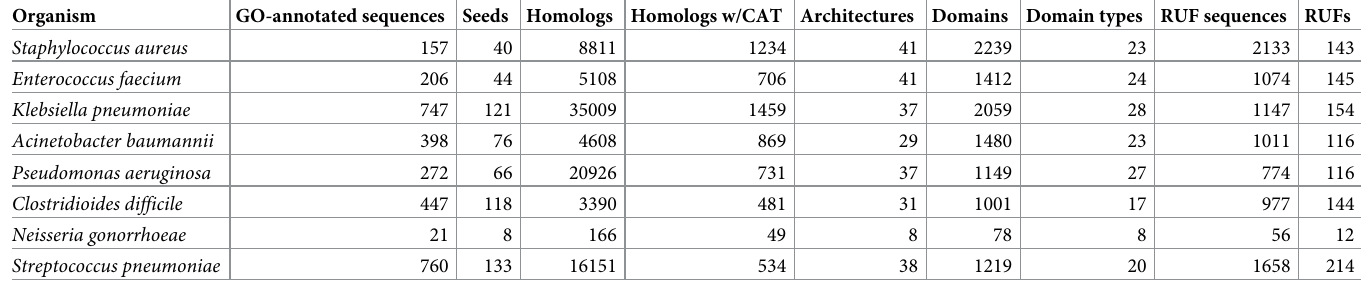
Table 1. LEDGOs database construction and composition. A breakdown, by organism, of the counts of the initial sets of sequences with relevant annotation for pepti- doglycan binding and catalysis function; representative seed sequences; identified sequence homologs; those homologs with catalytic domains; unique architectures; domain sequences; domain types; RUF sequences; and clustered